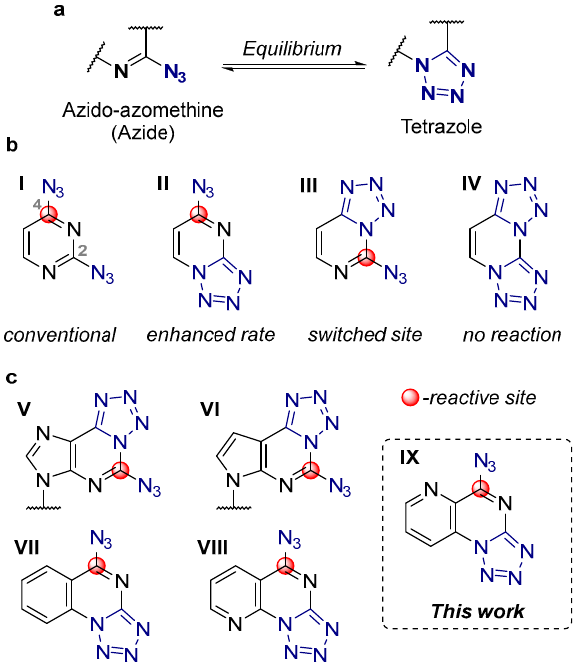
Figure 1. ( a ) Azide-tetrazole equilibrium; ( b ) reactivity of 2,4-diazidopyrimidines; ( c ) S N Ar regioselectivity in fused 2,4-diazidopyrimidines.